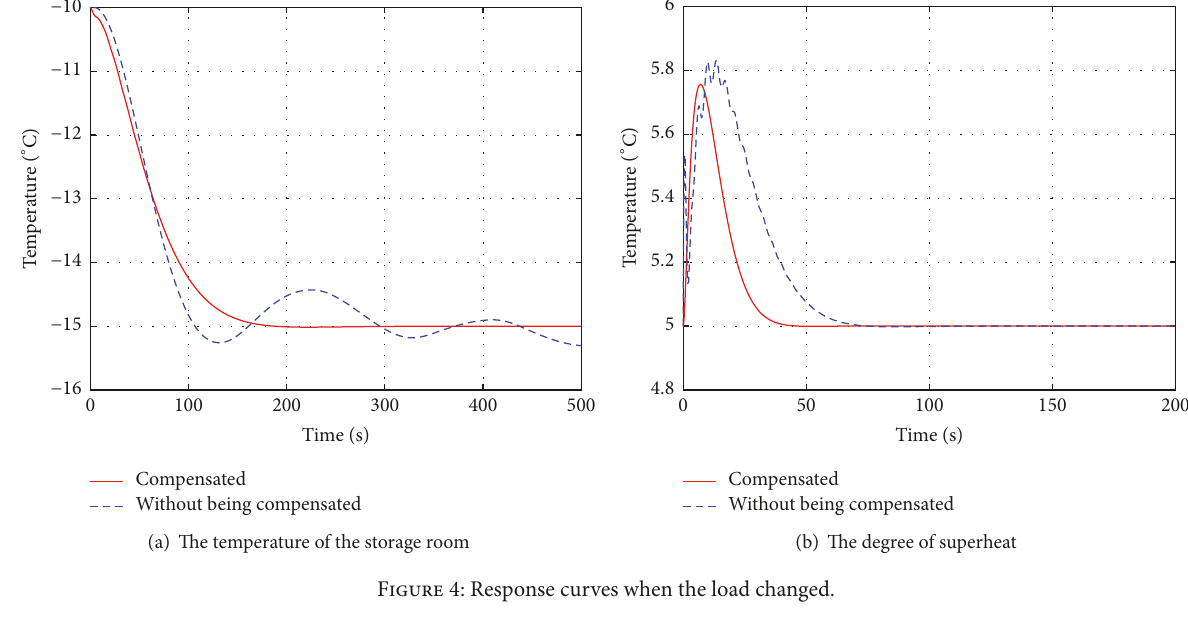
Figure 4: Response curves when the load changed.